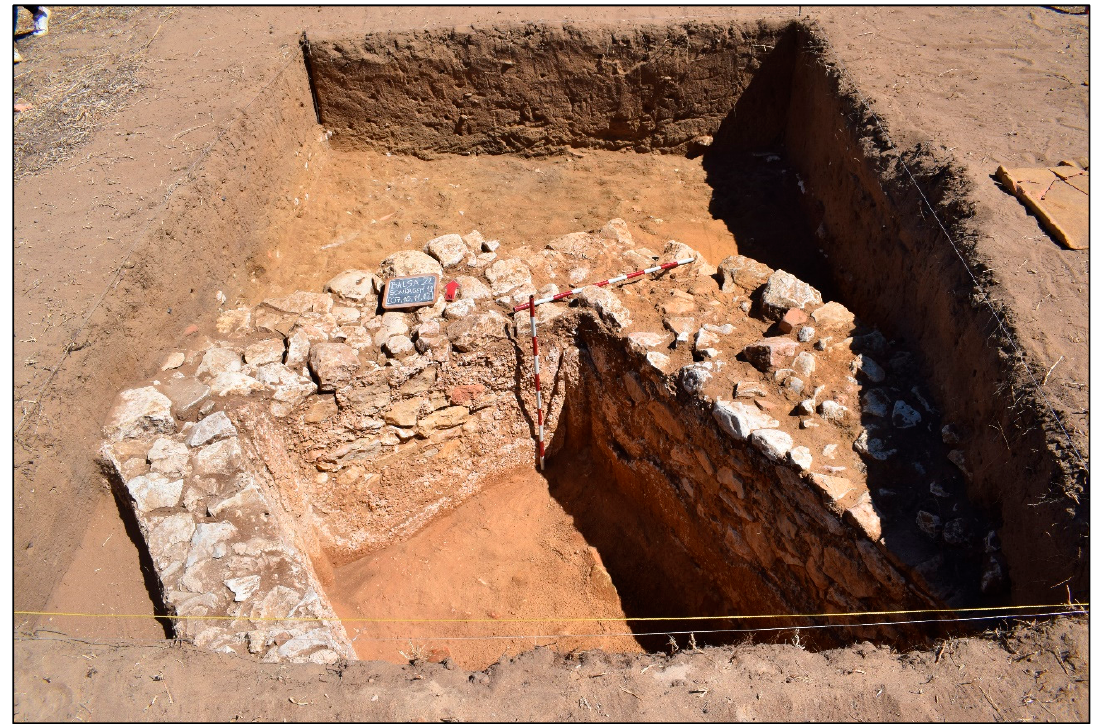
Figure 16. Sounding opened in P1-4 with a vat dedicated to the production of fish sauces.